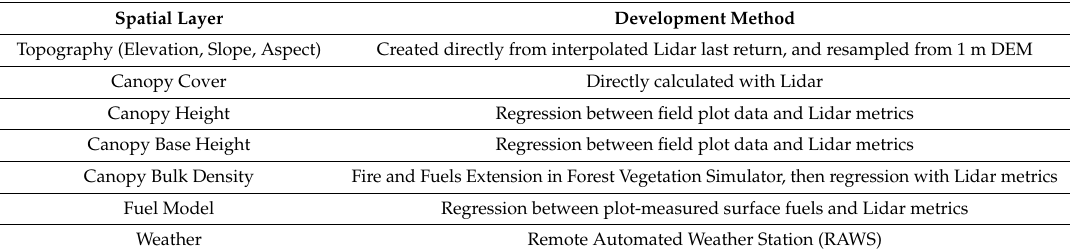
Table 1. Methods for generating the input layers used in